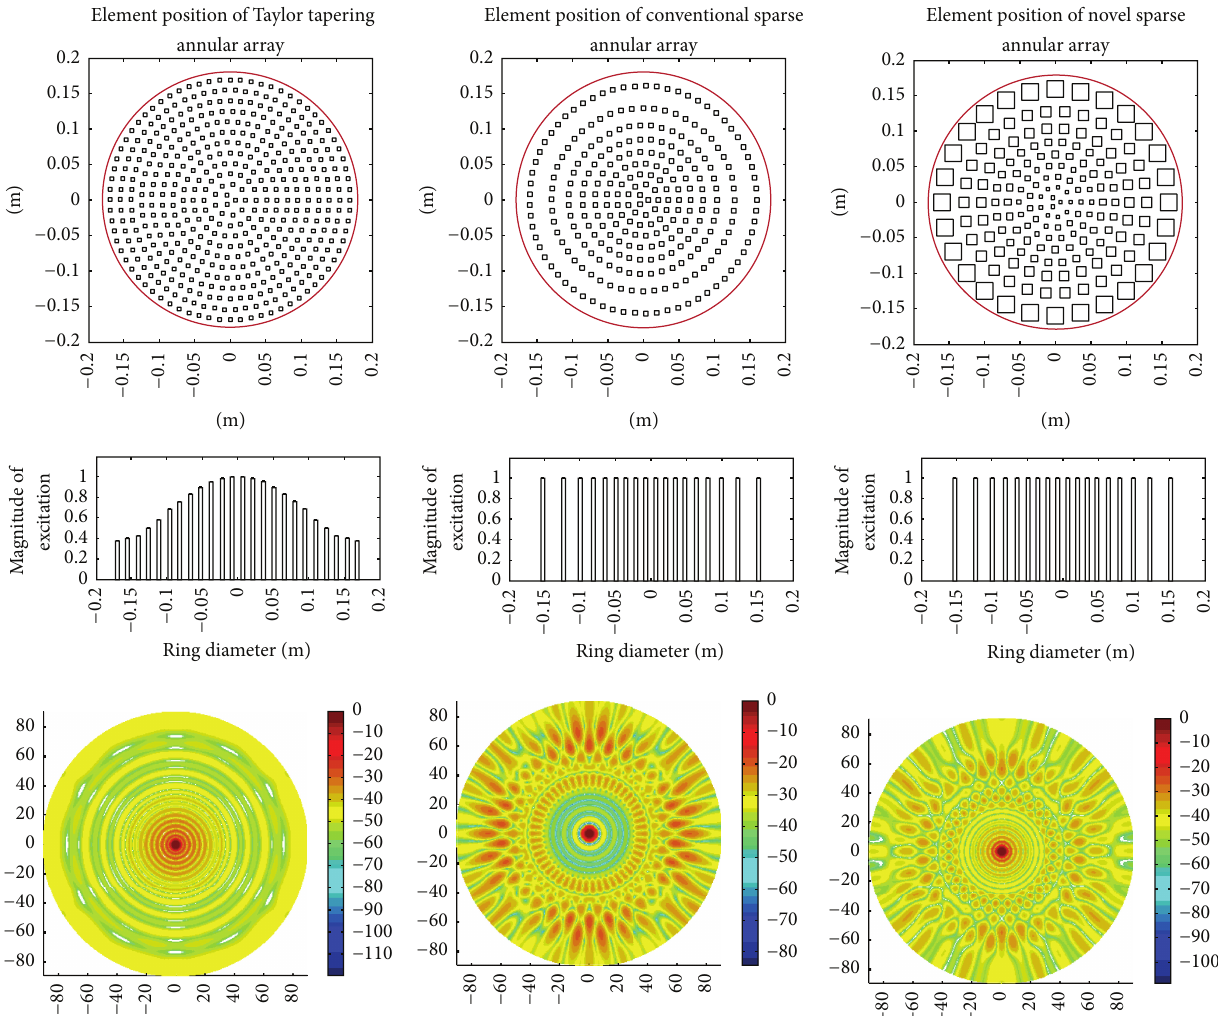
Figure 2: Synthesis results of annular periodic array (left column), conventional sparse array (middle column), and proposed high efficiency sparse array (right column). The array elements distribution (upper row), excitation distribution (middle row), and radiation pattern (lower row) are illustrated.